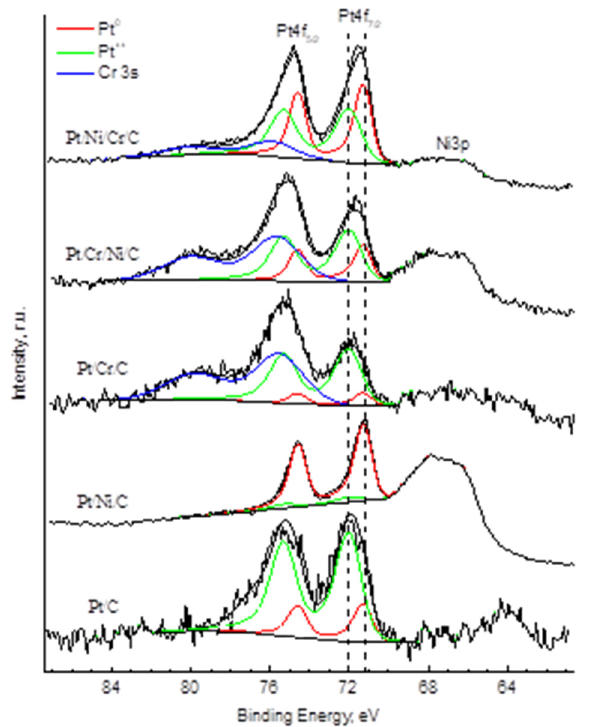
Figure 2. XP spectra of Pt 4f and Cr 3s electrons of Pt/C catalysts (C=C ox ; Pt—0.1 wt.%) after being reduced in H 2 .